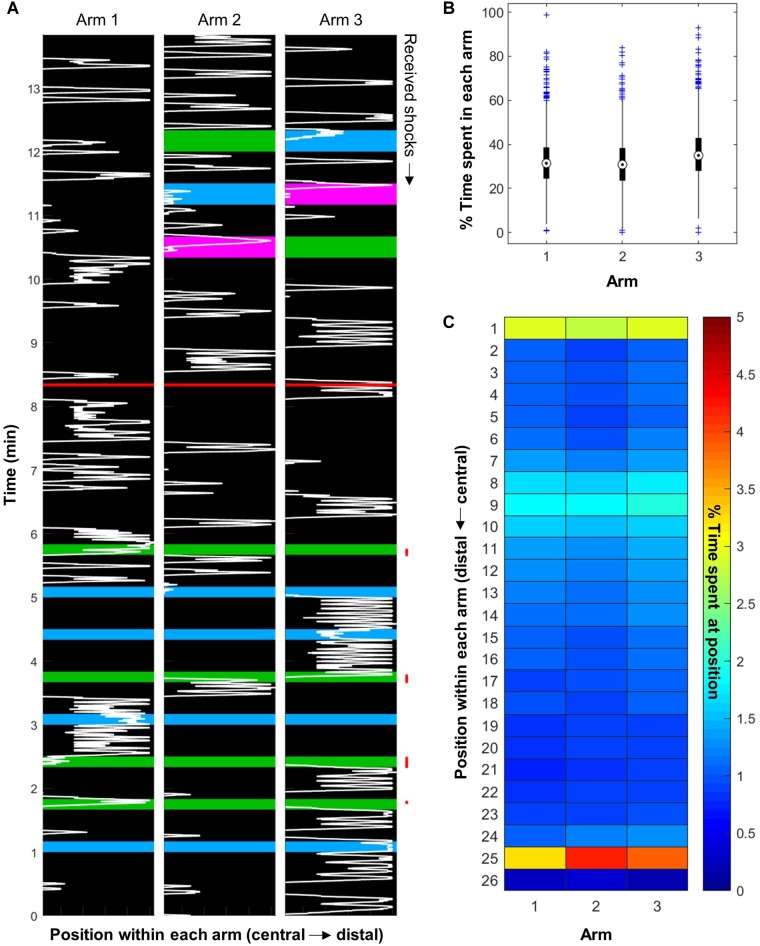
Honeybees explored the whole apparatus. (A) Representative example of bee movement inside the apparatus (bee trained with four training trials in the blue vs. green paradigm, with green shocked, and tested with all three color pairs). The background color represents the light inside each arm. The red line separates the training phase from the STM test. The red points on the right mark the received electric shocks. (B) The bees explored the whole apparatus, and had a slight preference for Arm 3 (n = 1216 bees). (C) Bees spent more time at the far end of each arm and in the central area. They also seemed to react to the presence of the vacuum, which is on top of position 9 (n = 576 bees).